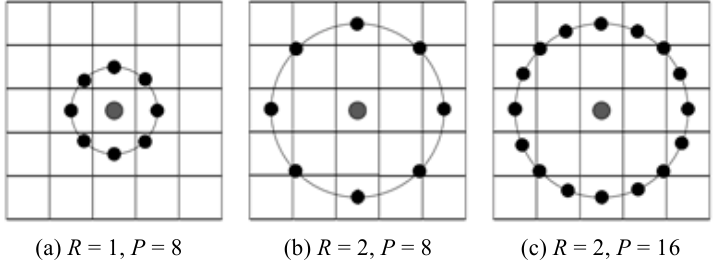
Figure 2. Principle of improved LBP.